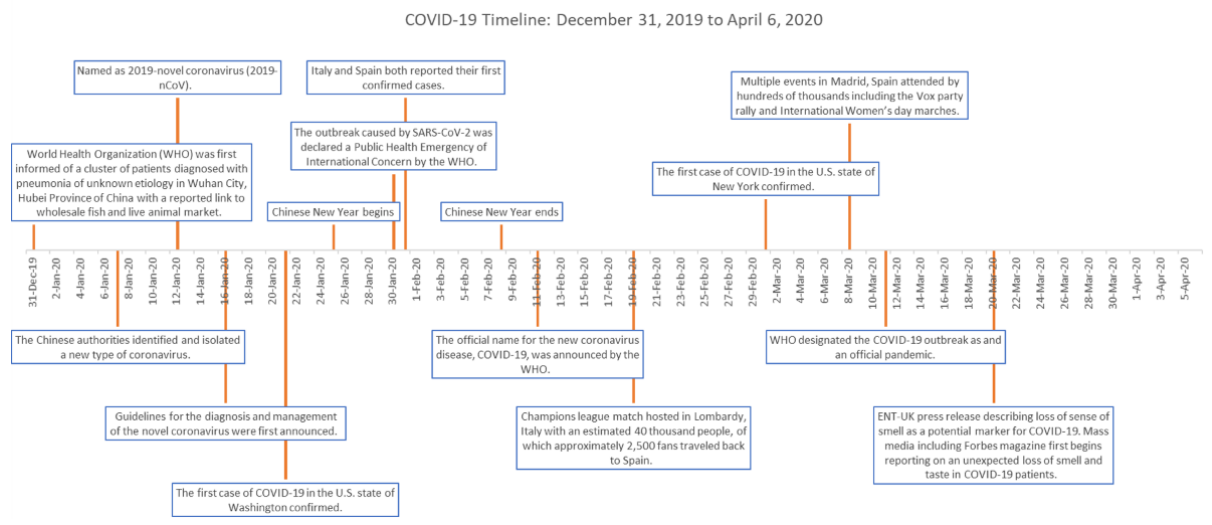
Figure 1. Timeline of real-world COVID-19 significant events. COVID-19: coronavirus disease; ENT-UK: British Association of Otolaryngologists; SARS-CoV-2: severe acute respiratory syndrome coronavirus